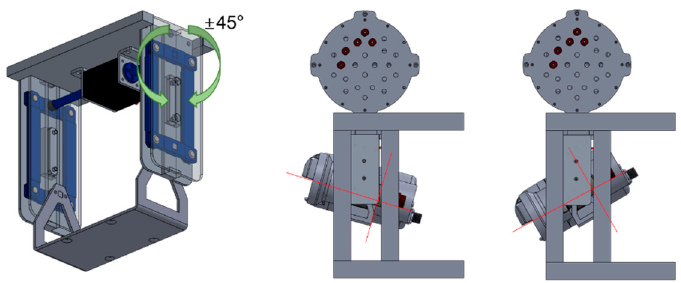
Figure 3. Schematic of the bracket equipped with a servo motor for tilting imaging sensors. Table 2. Specifications of two imaging sensors and the light in the optical-sonar fusion system.